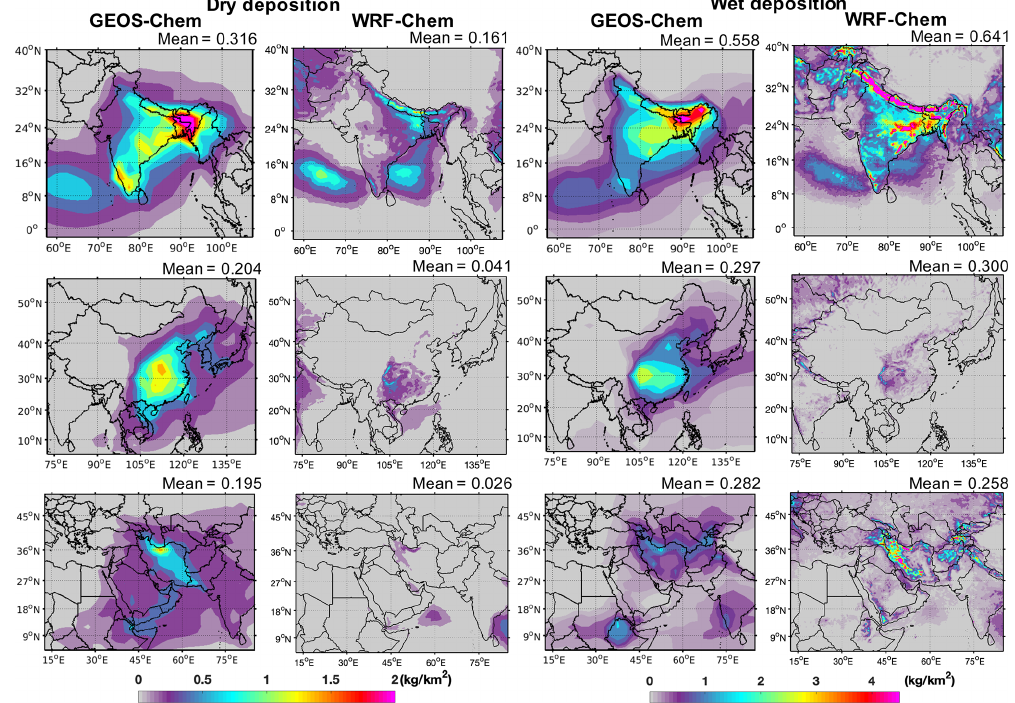
Figure 6. GEOS-Chem and WRF-Chem simulated annual total deposition rates of TFA (kilograms per square kilometer per year; hereafter kgkm − 2 yr − 1 ) from (a) dry and (b) wet deposition in India, China, and the Middle East domains. The number at the top of each panel gives the mean dry and wet deposition rates within the domains.